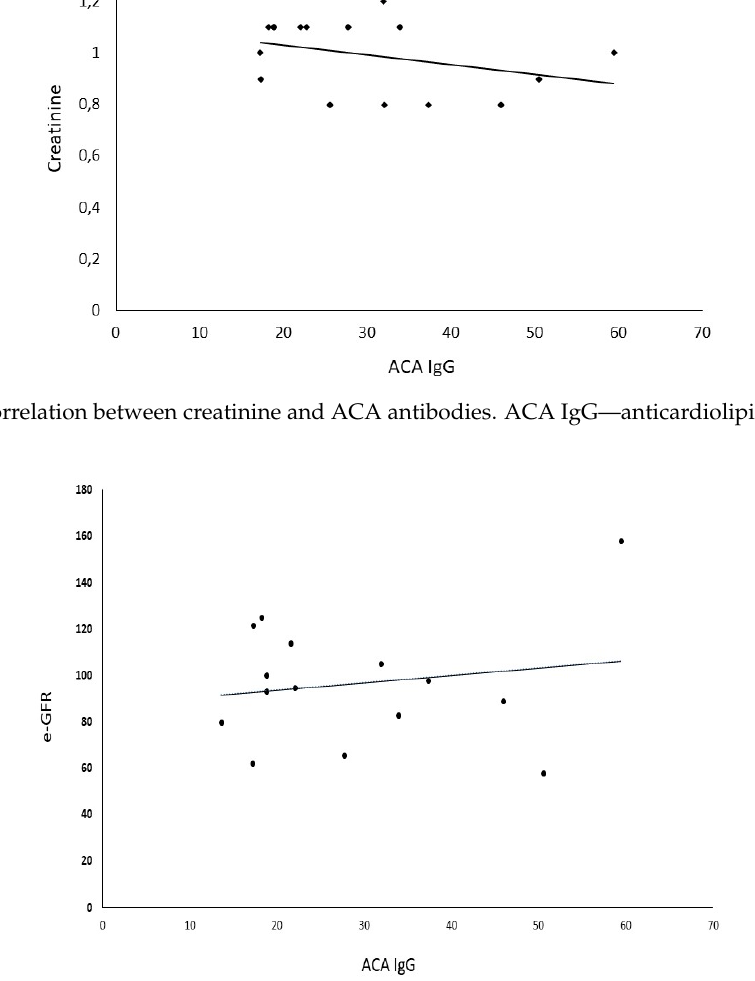
Figure 1. Correlation between sNGAL and ACA antibodies. sNGAL—serum Neutrophil gelatinase- associated lipocalin, ACA IgG—anticardiolipin antibodies type G.